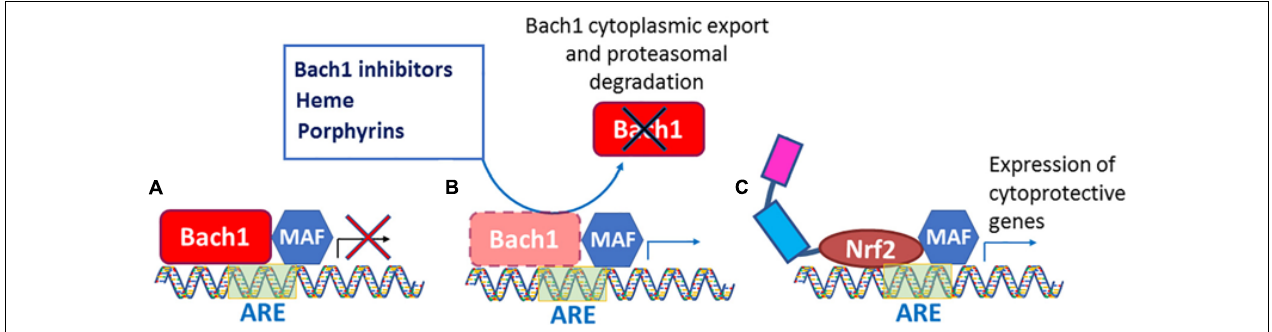
FIGURE 3 | Bach1 inhibition leads to constitutive Nrf2 activation. (A) Bach1 binds to ARE site present on the promoter to repress Nrf2 target genes. (B) Bach1 inhibitors, heme, and porphyrins de-repress Bach1 resulting in its cytoplasmic export and proteasomal degradation. (C) The Bach1 de-repression allows Nrf2 to bind to ARE sites and leads to constitutive activation of Nrf2 pathway to overexpress cytoprotective genes.